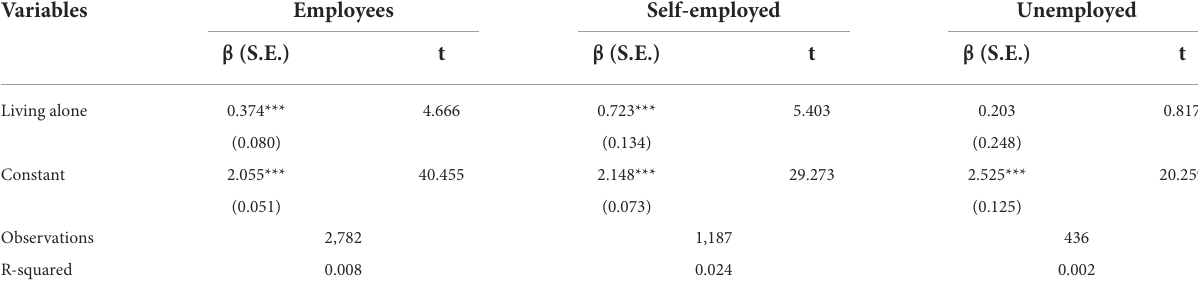
TABLE 5 Effect of live alone on mental health, by employment.